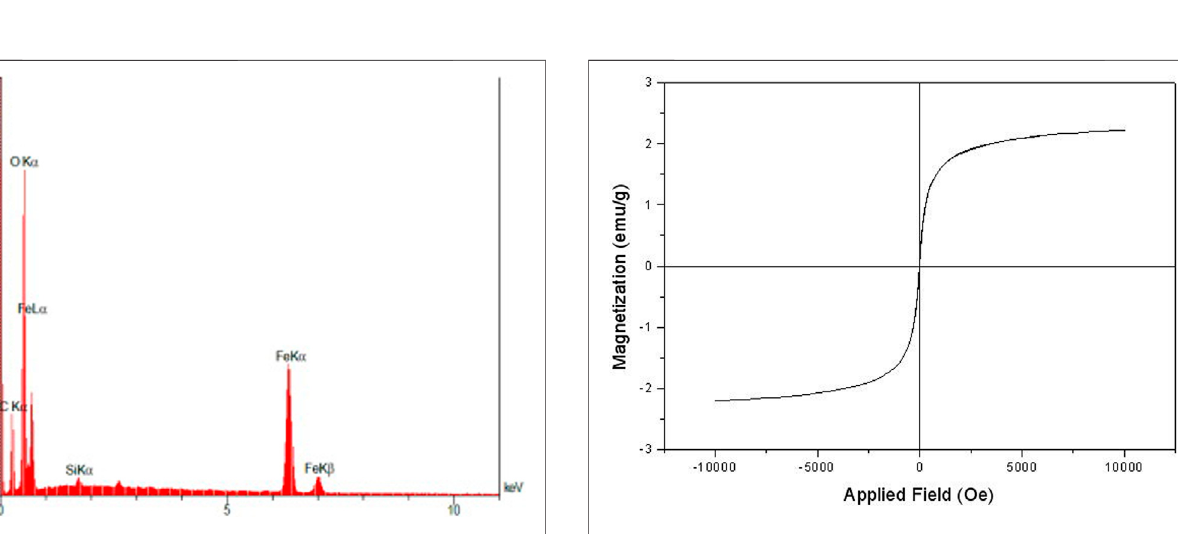
FIGURE6| EDXimageofsynthesizedFe 3 O 4 @SiO 2 @TannicacidMNPs.